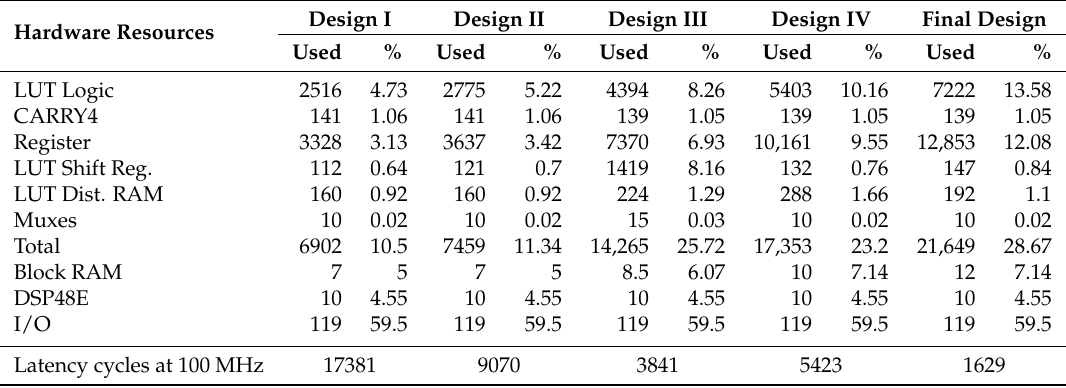
Table 5. Hardware designs resource utilization and